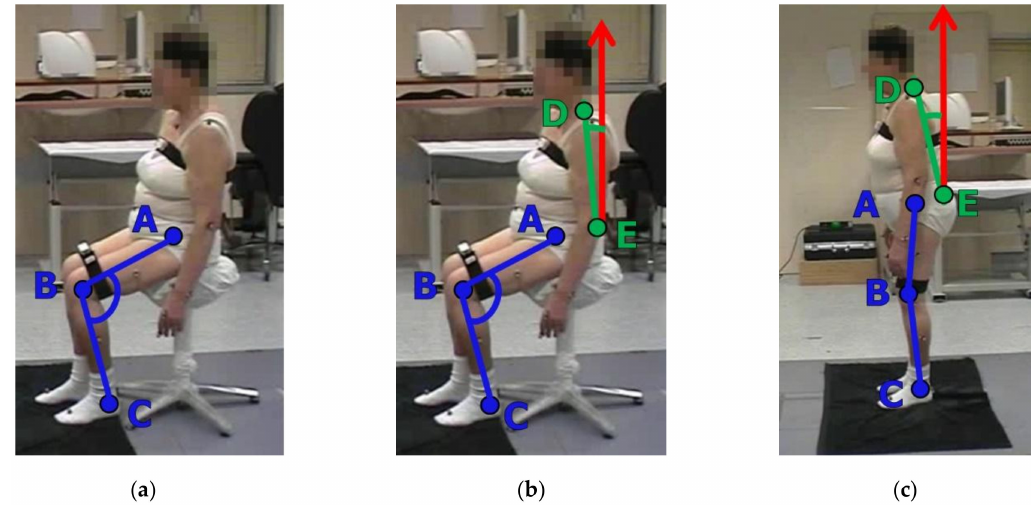
Figure 5. Segments involved in the estimation of the angular measures during lower limbs and postural tasks: ( a ) LA task ( b ) AC task ( c ) Po task. Note that the depth axis of the Kinect device is perpendicular to the subject frontal plane in all the tests, see Section